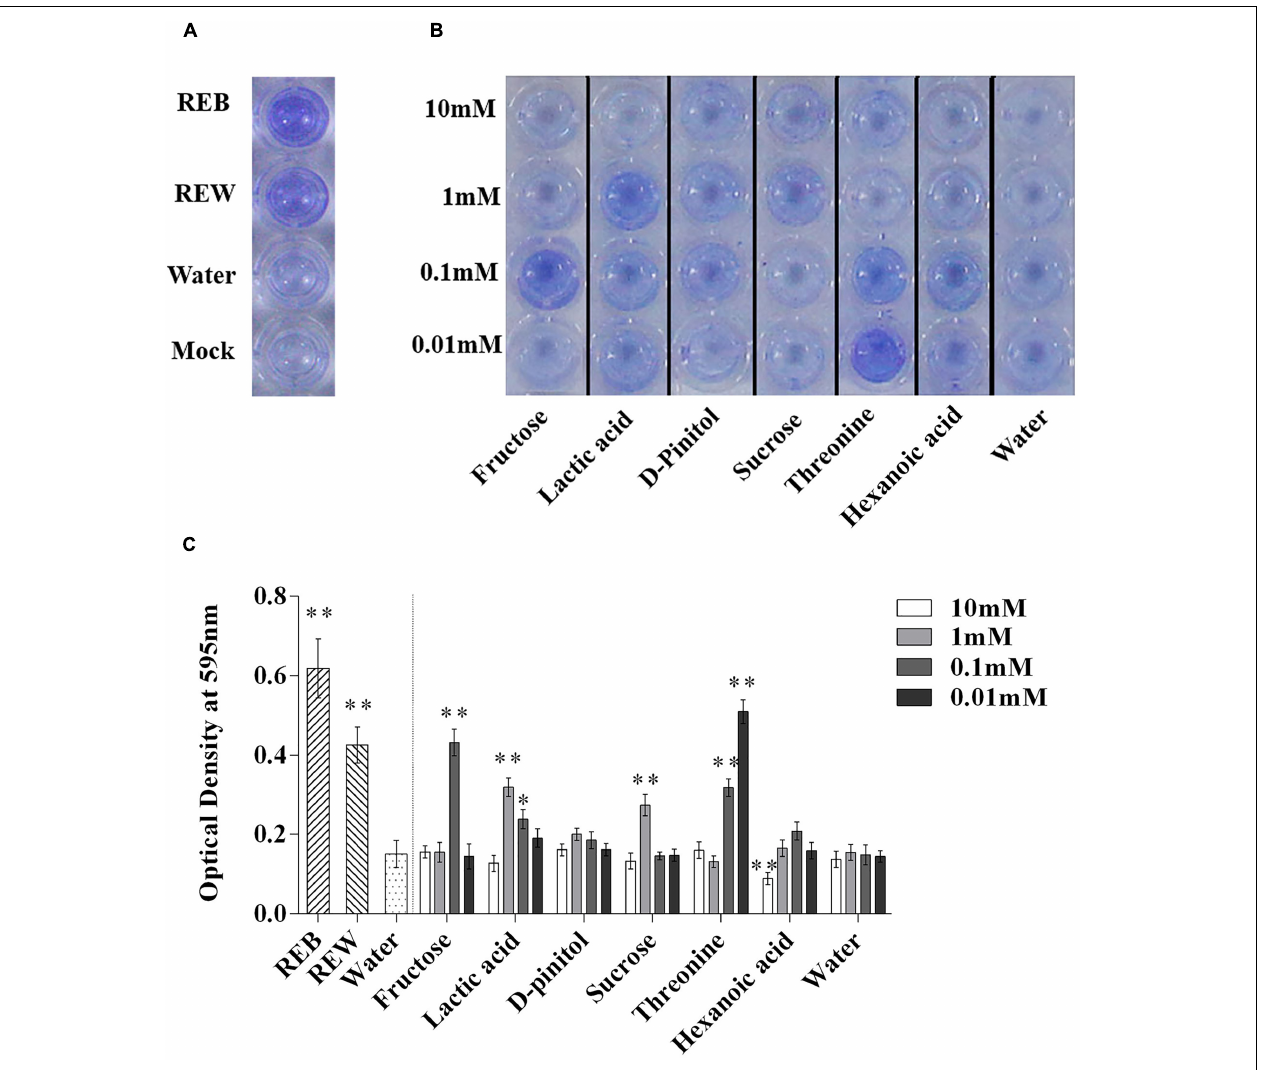
FIGURE 8 | Biofilm formation on polystyrene microtiter plates by Bacillus cereus AR156 with still at 30 ◦ C for 48 h under microaerobic conditions. Biofilm formation were determined by crystal violetin in the 96-well microtiter plate induced by Bacillus cereus AR156 (REB), tomato root exudate induced by water (REW) (A) or different components from tomato root exudates induced by B. cereus AR156 (B) . (C) Relative optical density of B. cereus AR156’s biofilm was measured at 595 nm with a microtiter plate reader. The mean and standard error values of three biological replicates are reported for each treatment. Asterisks in (C) indicate statistical significance difference between data of treatments and data of sterile water as determined by the Student’s t -test ( ∗ P < 0.05, ∗∗ P < 0.01). The experiment was carried out three times and one representative experiment is